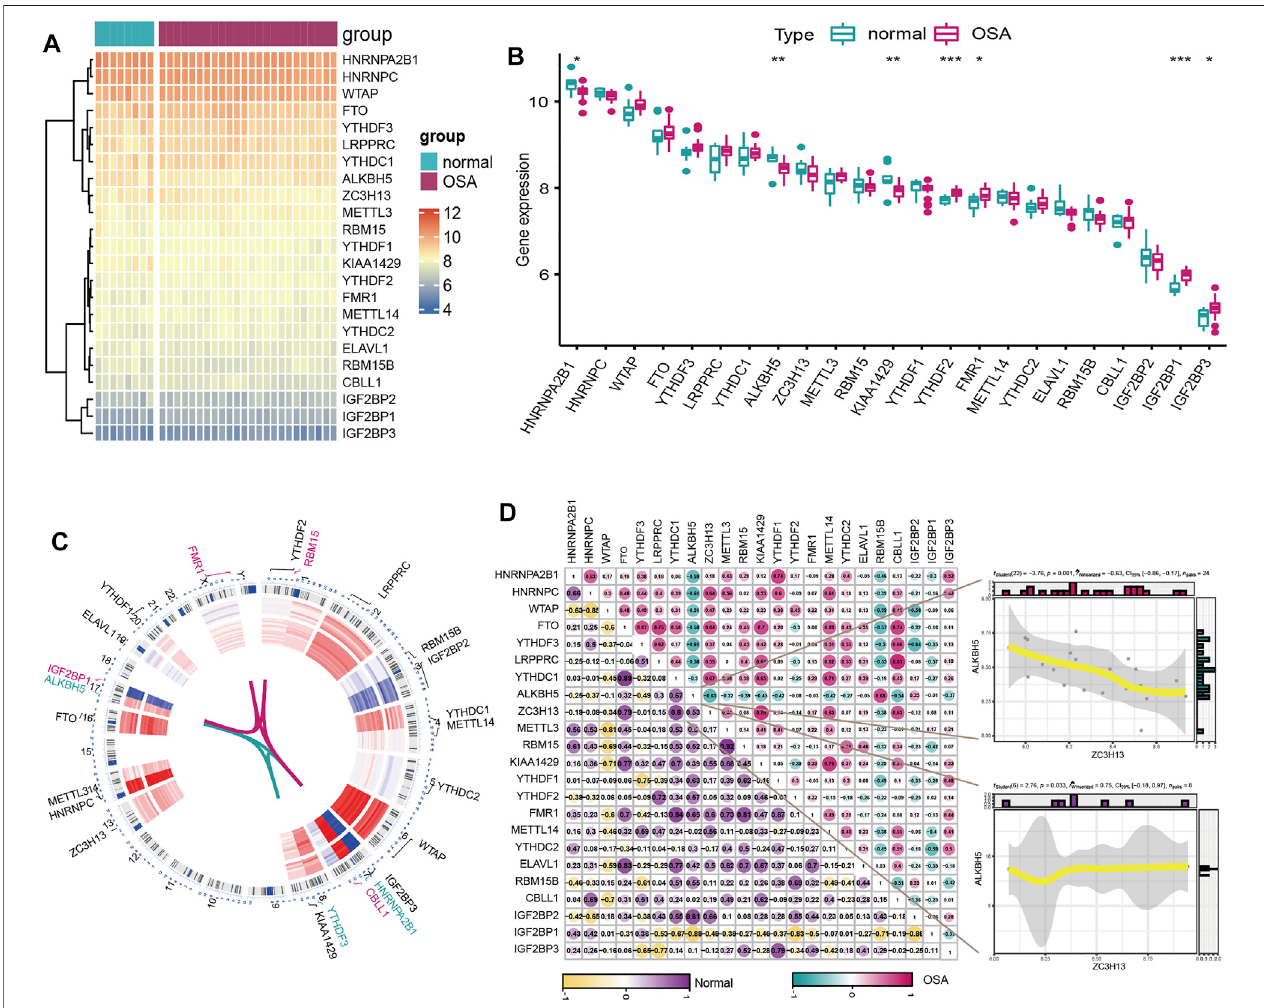
FIGURE2| Theexpressionpatternofm6AregulatorsinsevereOSAandcontrolindividualsbasedontheGSE135917dataset. (A) Heatmap and (B) boxplotof23 m6A genes expression between normal and severe OSA subjects. (C) Chromosomal positions and expression of the 23 m6A regulators. (D) Correlations of 23 m6A regulators in normal and OSA samples. The two scatter plots demonstrated the changes of correlations of ZC3H13 and ALKBH5 between severe OSA and normal subjects.